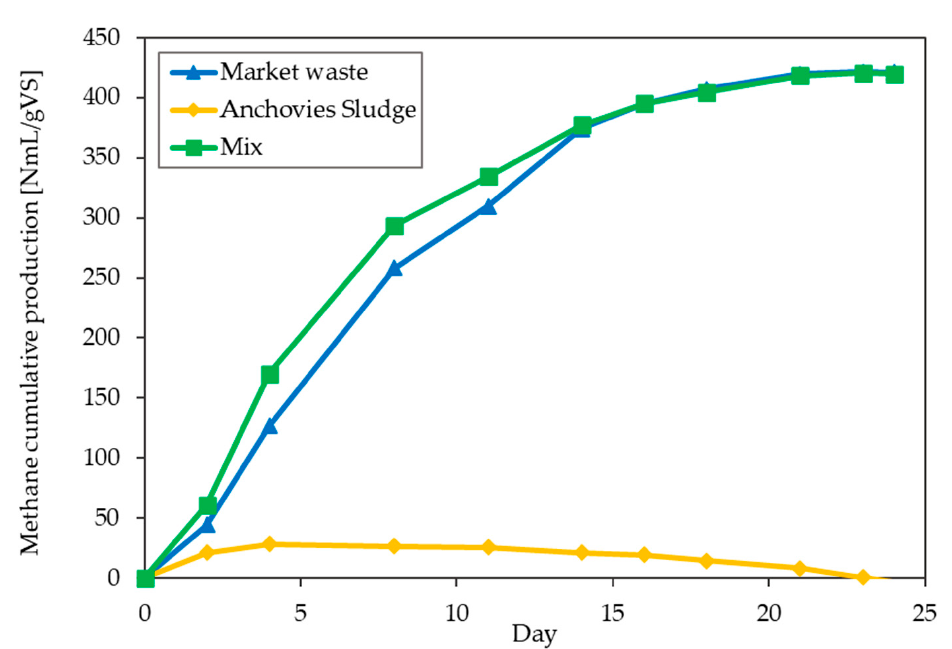
Figure 2. Methane cumulative production during BMP tests.